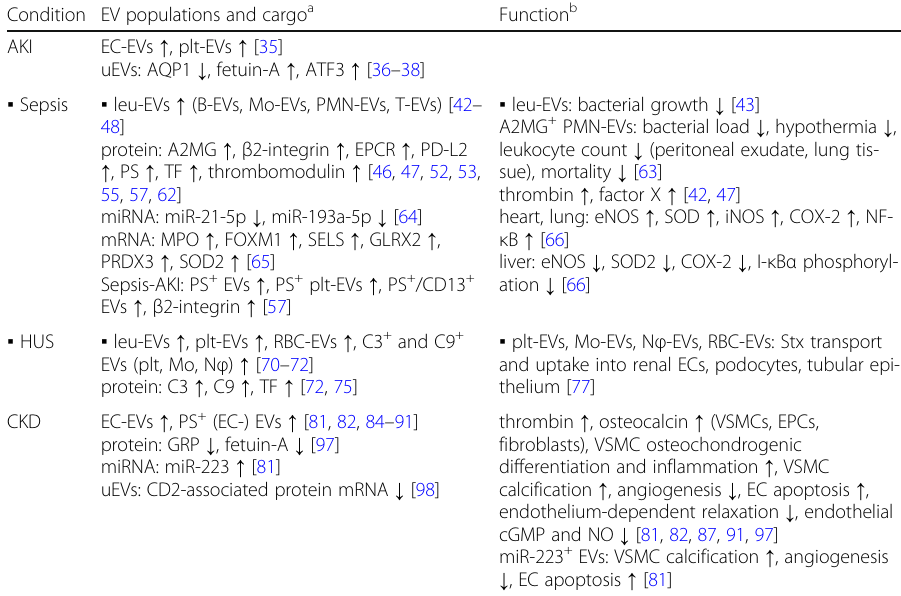
Table 3 Changes in EV characteristics upon different forms of kidney disease Condition EV populations and cargo a Function